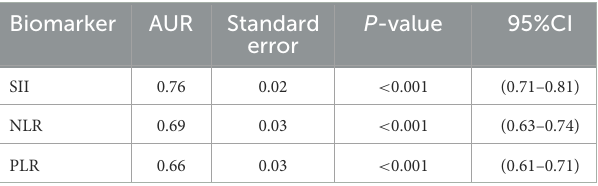
TABLE 5 Receiver operator characteristic (ROC) curve of the systemic immune-inflammation index (SII), neutrophil/lymphocyte ratio (NLR),